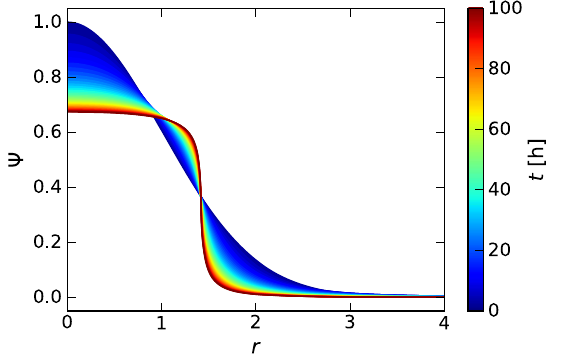
5 × 10 − 5 , b 0 , FIG. 4. Distribution evolution with a x ¼ x ¼ 0 . 01 , and noise of σ 5 × 10 − 4 , based on Eq. (18). The g x ¼ k ¼ time is given by the color scale, going to 100